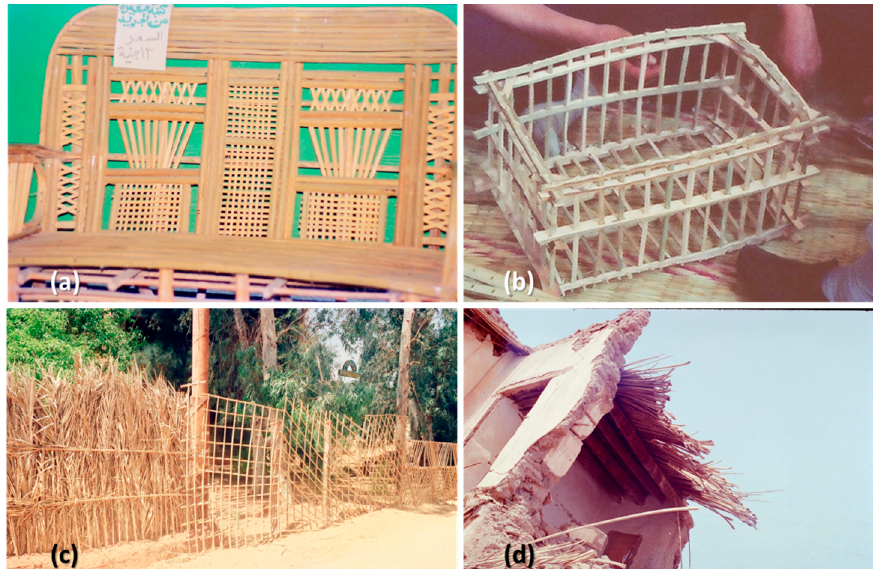
Figure 1. Examples of the technical heritage of date palm midribs in Egypt. ( a ) Traditional furniture made from date palm midribs (Fayoum, Egypt). ( b ) Traditional fruit crate made from date palm midribs (Giza, Egypt). ( c ) Traditional fencing by date palm midribs (The New Valley, Egypt). ( d ) Roofing using date palm midribs and date palm trunks (Asuit, Egypt).